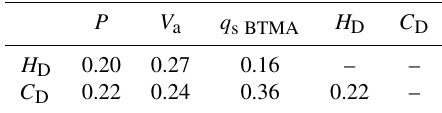
Table 1. Coefficient of determination (COD) between dune param- eters and acoustic methods (log